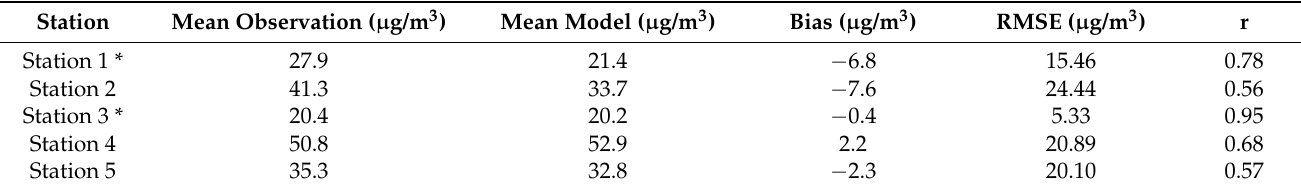
Table 1. Statistical evaluation of the model performances for hourly NO 2 concentrations on five monitoring stations during 359 days of year